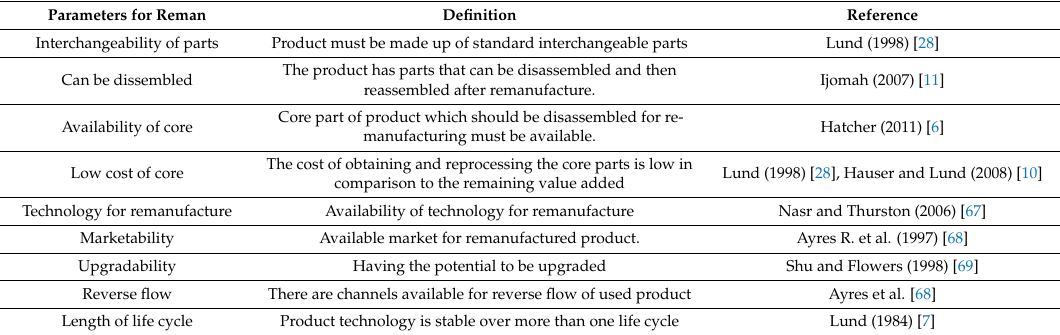
Table 1. Parameters for